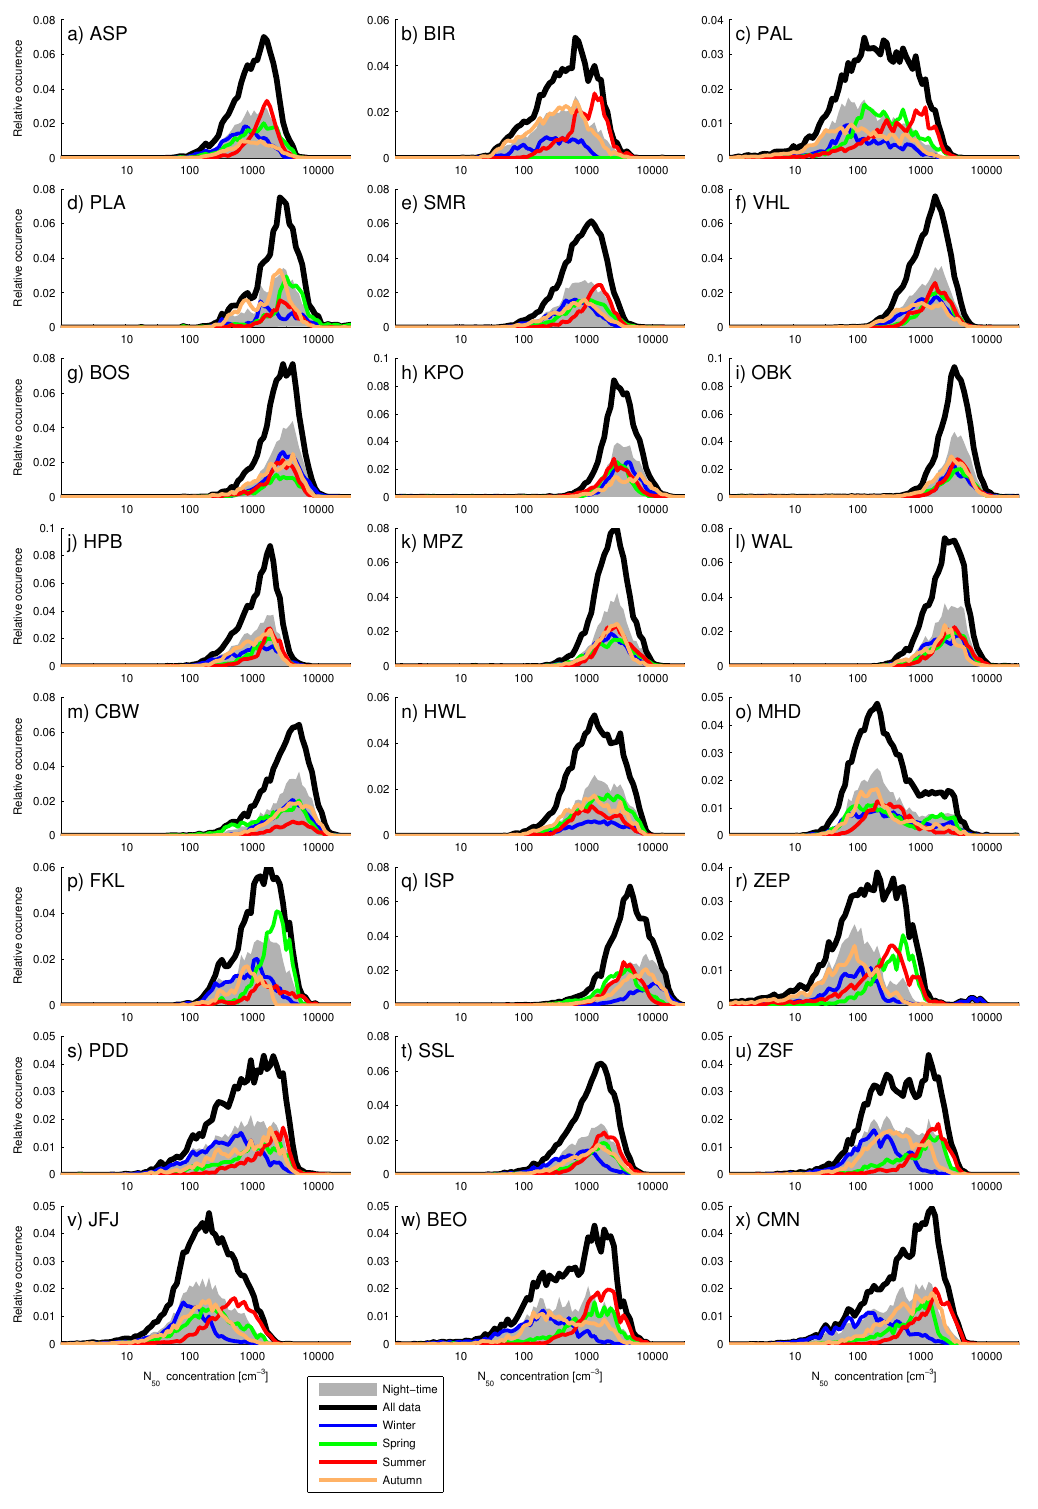
Fig. 10. Histograms of N 50 concentrations at the stations. See Fig. 9 for